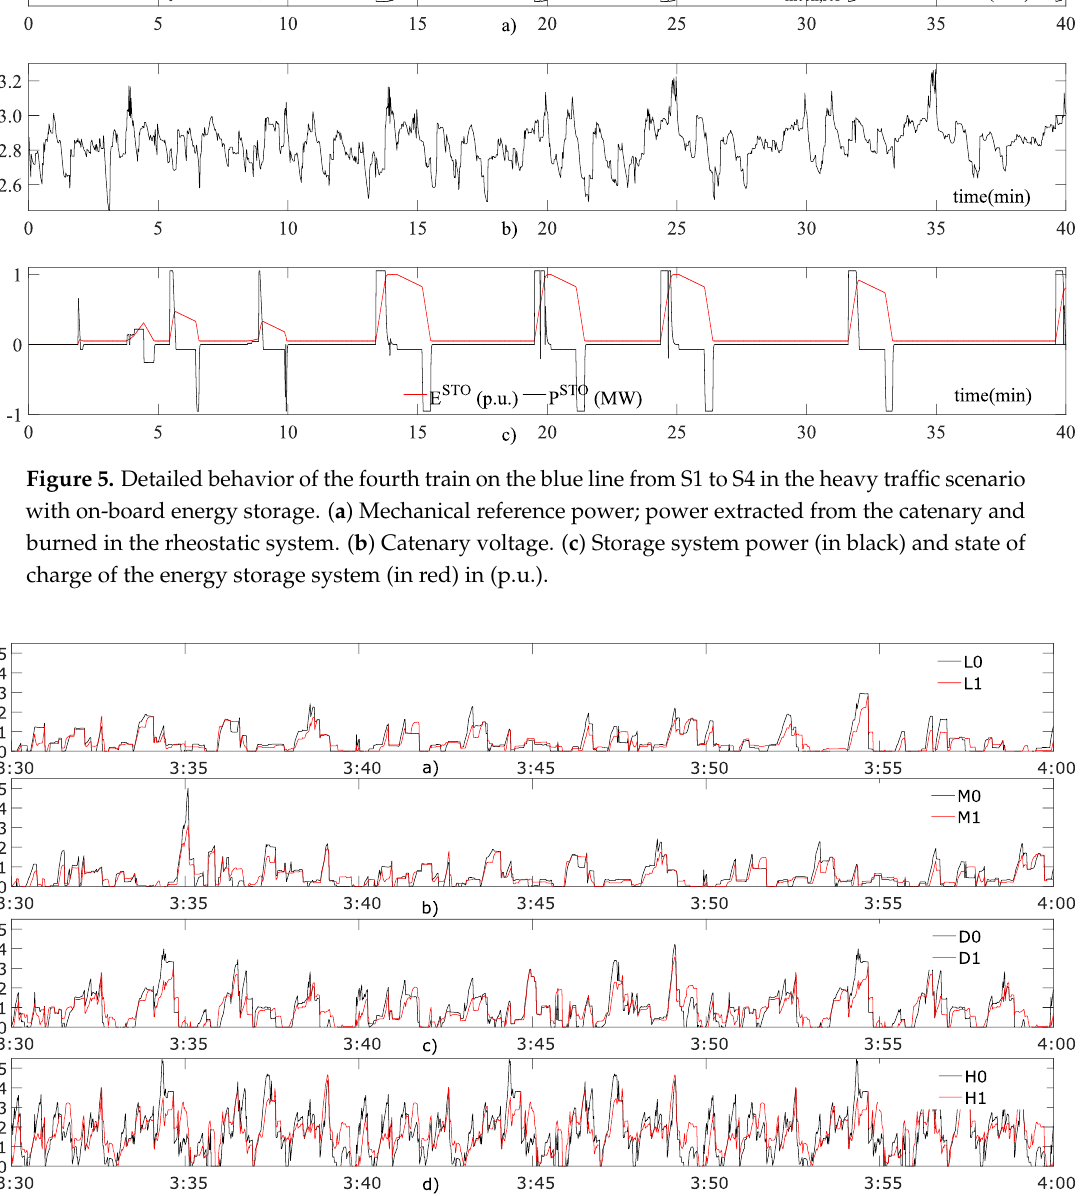
Figure 6. Power in MW obtained from the AC grid by substation S5 on the red line for all scenarios. ( a ) Light Traffic Scenario; ( b ) Medium Traffic Scenario ( c ) Dense Traffic Scenario; ( d ) Heavy Traffic